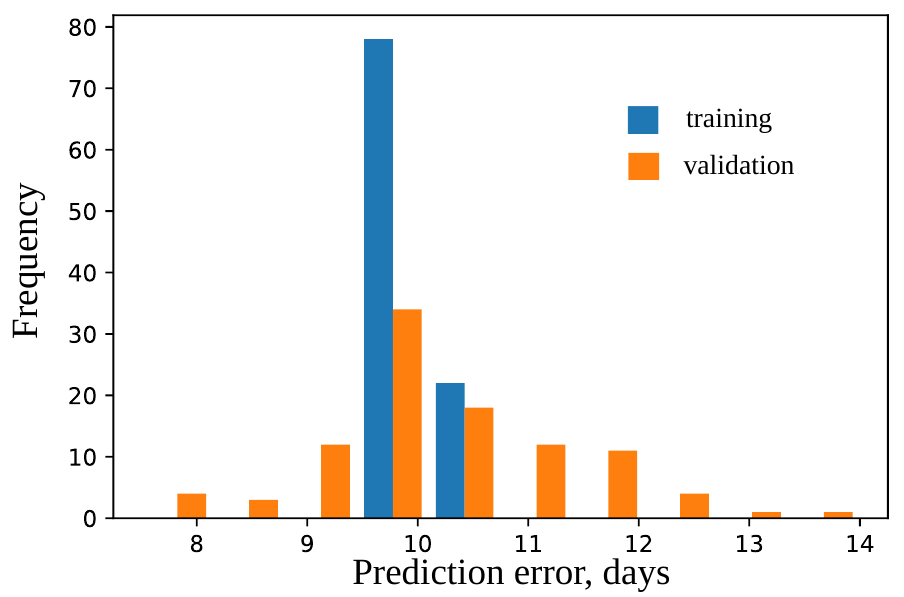
Figure 6. Histogram of errors in days for training and validation sets for models for the union SNP set. Mean values are 10.105 and 10.2575, respectively.